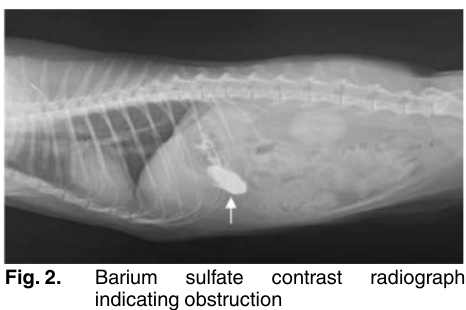
Fig. 2. Barium sulfate contrast radiograph indicating obstruction